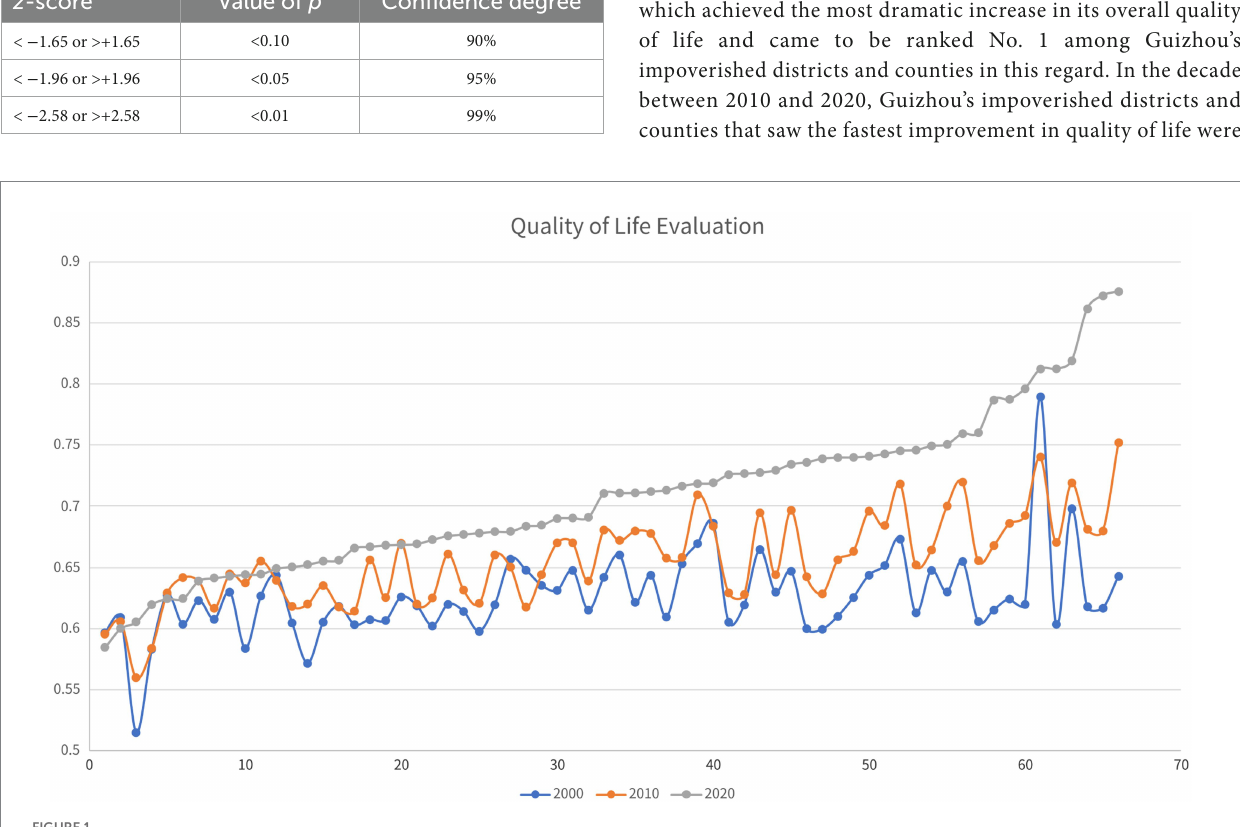
FIGURE 1 Analysis of the evolution of the quality of life of Guizhou’s districts and counties from 2000 to 2020.